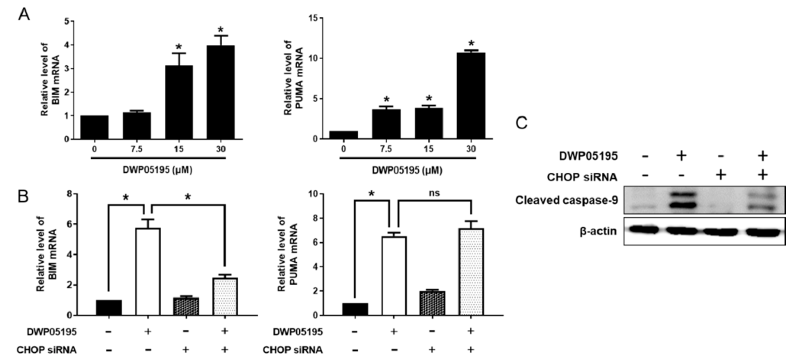
Figure 4. Involvement of CHOP in DWP05195-stimulated intrinsic apoptosis pathway. ( A ) A2780 cells were treated with 0, 7.5, 15, and 30 μ M DWP05195 for 24 h. BIM (Bcl2-like11) and PUMA (p53 upregulated modulator of apoptosis) levels were determined by real-time RT-PCR. * p < 0.05 compared with control. ( B ) After the CHOP knockdown, BIM and PUMA levels were detected by real-time RT-PCR and ( C ) cleaved caspase-9 levels were detected by Western blotting Uncropped blots of Figure 4C are shown in Figure S1. Results are representative of at least three independent experiments. * p < 0.05.